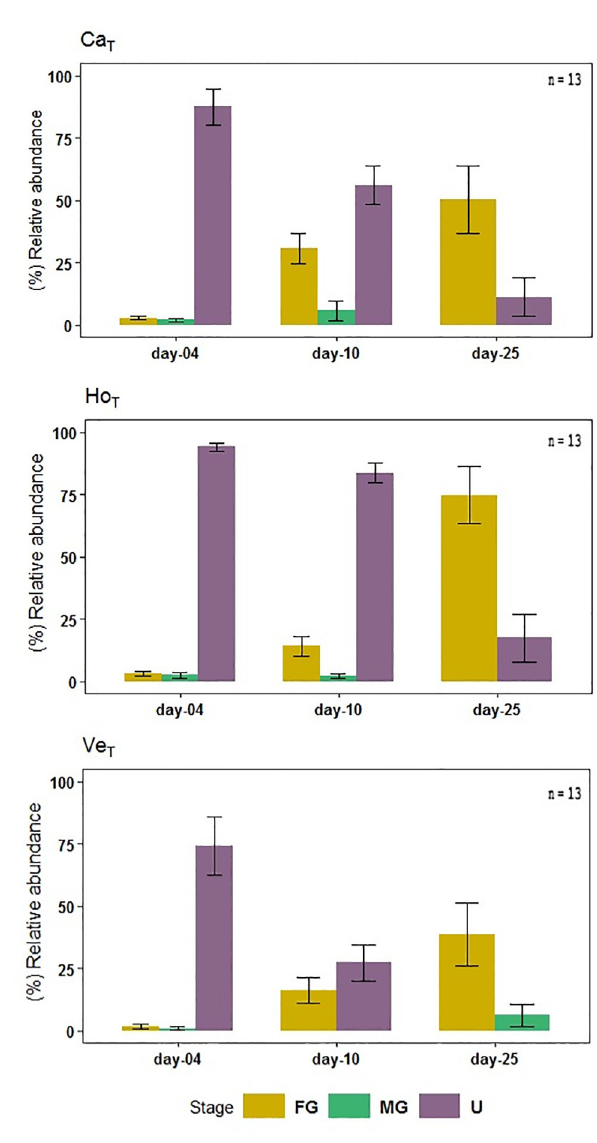
Fig 8. Sexual differentiation. Development from undifferentiated gametophyte to sexual gametophytes during 25 days of exposure to treatment, showing SD (n = 13). The legend indicates the different stages: Undifferentiated gametophyte (U), Female gametophyte (FG) and Male gametophyte (MG) (S2C–S2E Fig). Ca; Cachagua, Ho; Horco´n, Ve; Ventanas. T; treatment.